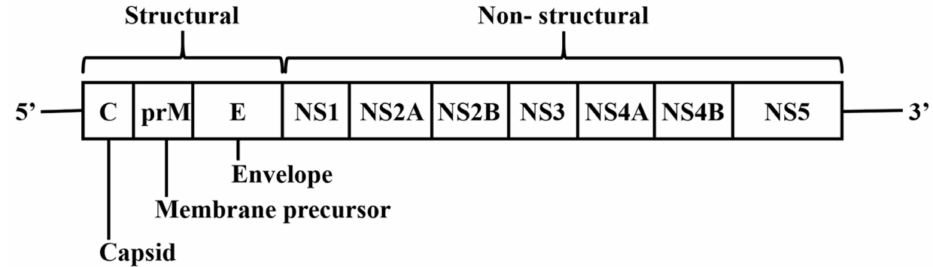
Figure 1. Schematic representation of the DENV genome and the encoded